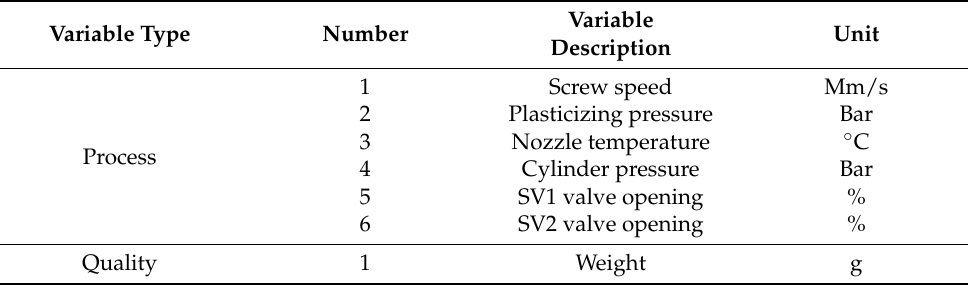
Table 1. Process and quality variables of an injection molding process.